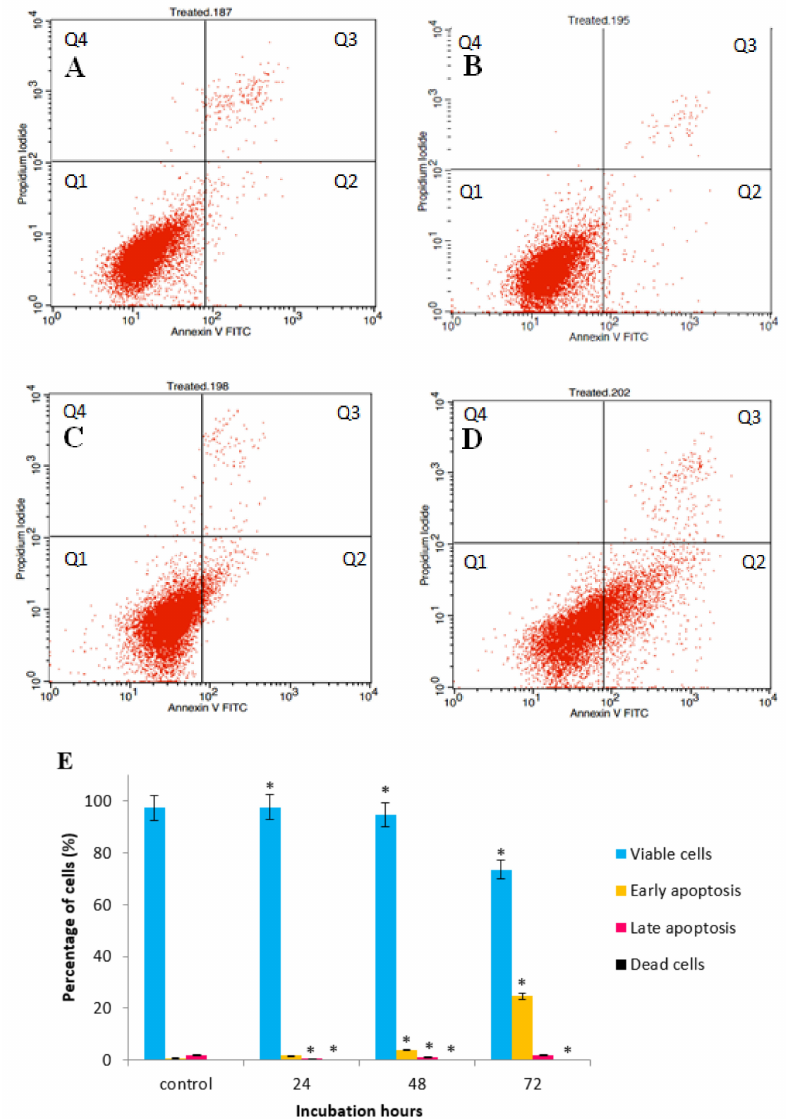
Figure 4. Flow cytometric analysis was performed to determine apoptotic activity in GNST-ITC-treated HepG2 cells by Annexin-V / PI double staining. HepG2 cells were treated for 24, 48, and 72 h: ( A – D ) control and 24 h, 48 h, and 72 h treated cells respectively. ( E ) Bar chart shows percentage of cell distribution after the treatment. Values are presented as means ± SD of triplicate experiments. Significant di ff erence ( p < 0.05) as compared to control is indicated by